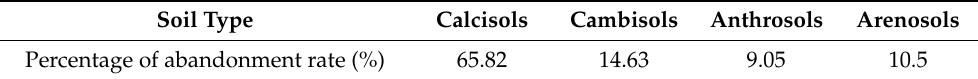
Table 6. Percentage of abandonment rate of different soil